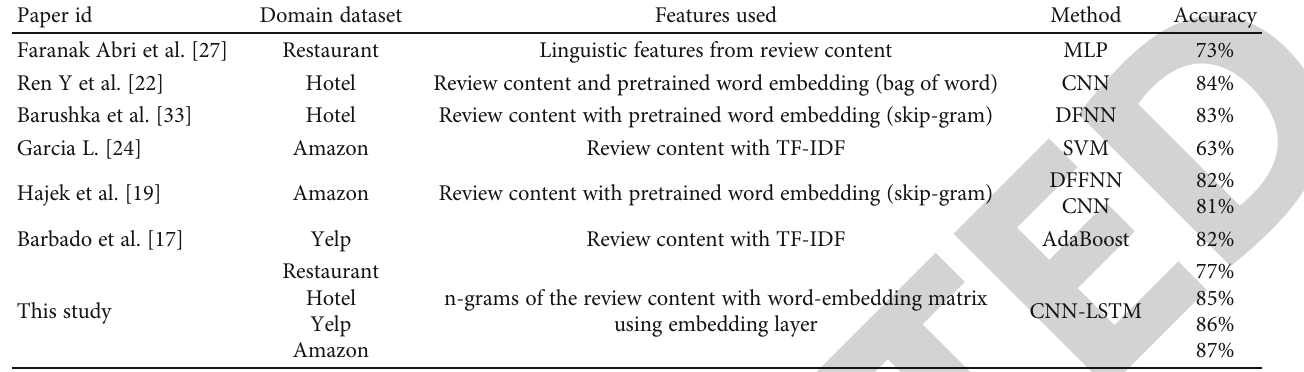
Table 4: Comparing the results of an in-domain datasets with existing